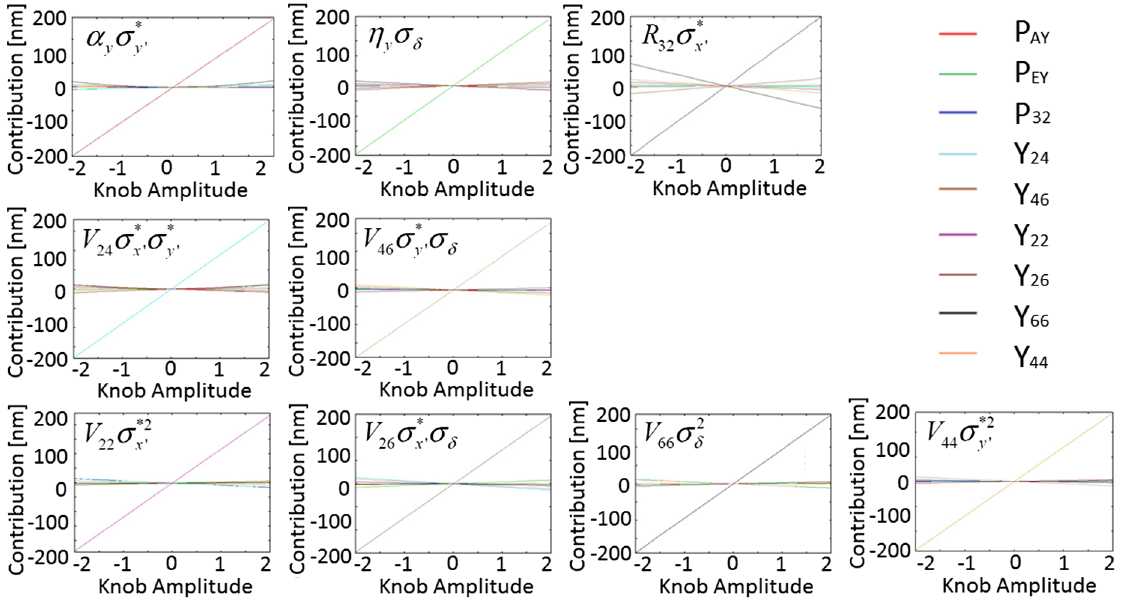
FIG. 10. Simulation result showing the orthogonality of the linear and second order knobs. The strength of each knob is normalized so that setting a knob amplitude of 1 contributes 100 nm of vertical beam size at the IP. The simulation was written using the 1 × 1 optics.